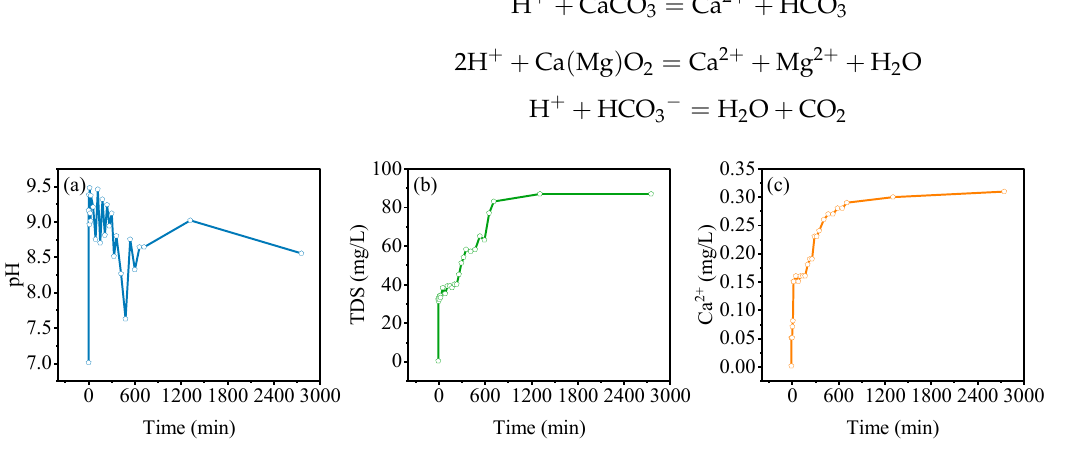
Figure 9. Solution characteristics of medium-grained coarse sandstone after leaching with deionized water: ( a ) pH value; ( b ) TDS concentration; ( c ) Ca 2+ concentration.